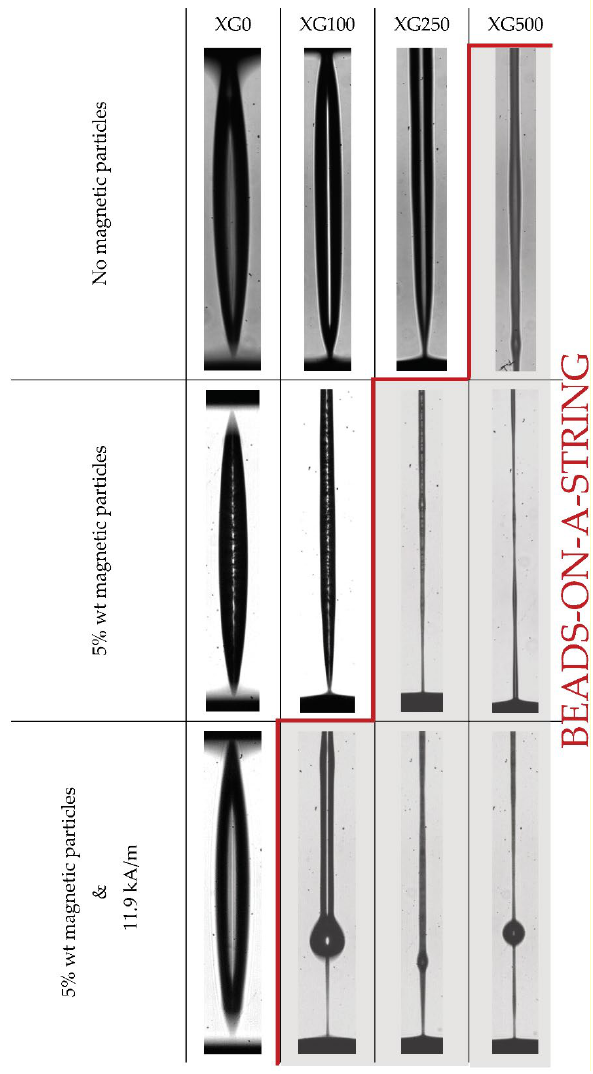
Figure 7. Filament silhouette of the different liquid filaments right before breakup. Beads-on-a-string structures are promoted by the presence of the particles under the external magnetic field.